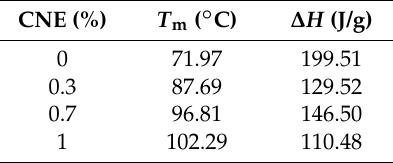
Table 4. Thermal properties of ABS films containing various amounts of cocoa nibs extract.